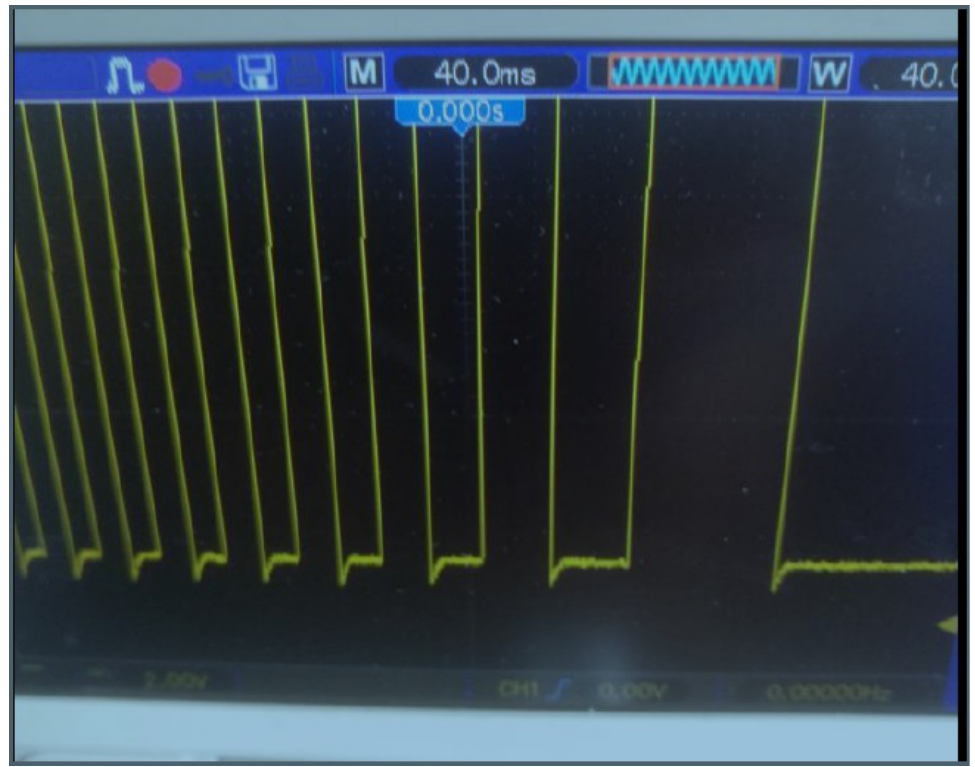
Figure 10. The noise on pulse image of the flow